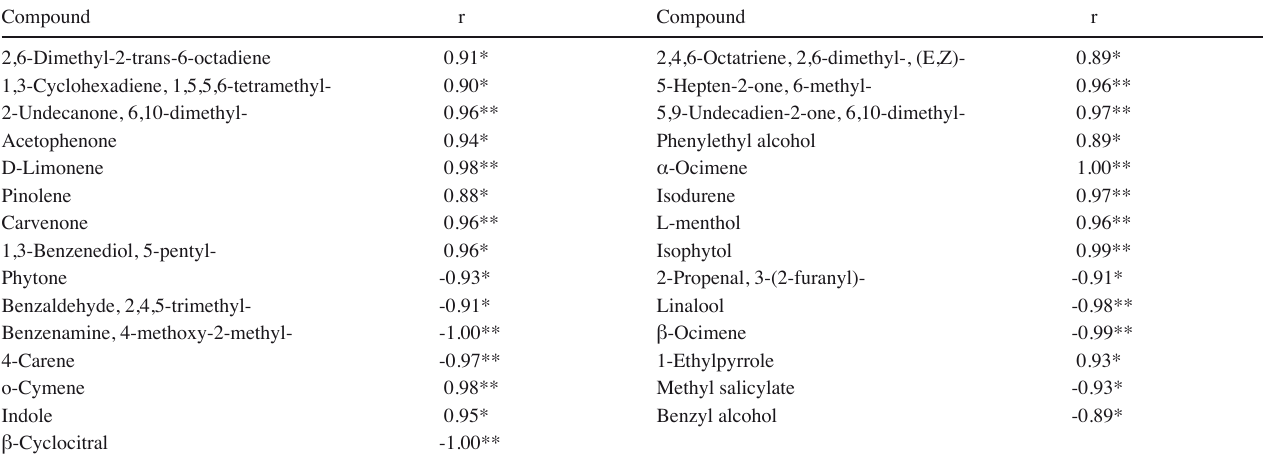
Tab. 4: Correlation analysis of different compounds and principal component 1